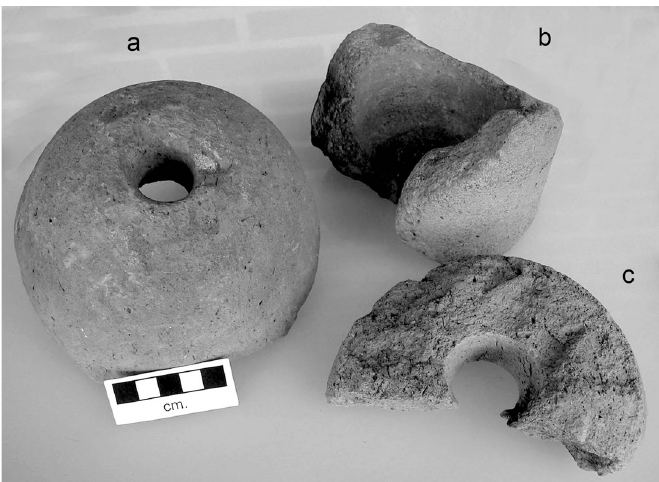
Figure 19: Sherds from large crude sugar - processing vessels, recovered from survey of an early sugar hacienda site in the valley.